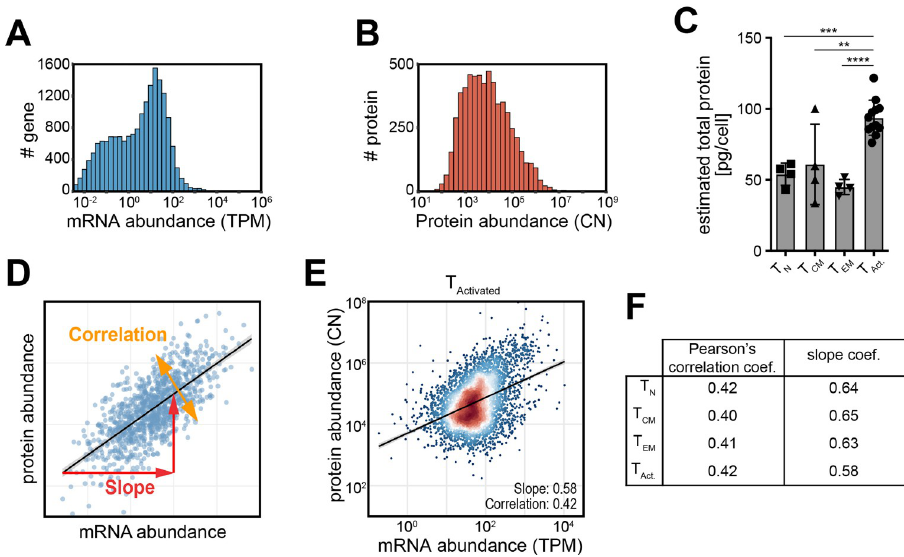
Fig 1. Transcriptome and proteome integration in human CD8 + T cells. ( A, B ) mRNA abundance in transcript per kilobase per million (TPM) and protein abundance data in protein copy number (CN) of CD8 + T cells that were activated for 2 days with α CD3/ α CD28, cultured for 4 days, and were then re-activated for 4h with PMA-Ionomycin (T Activated ; n = 12; from [23]). ( C ) Estimated protein mass per cells using the proteomic ruler methodology [25] of blood-derived, na ï ve (T N ; CD45RA + CD62L high ; n = 4), central memory (T CM ; CD45RO + CD62L high CX3CR1 - ; n = 4) and effector-memory (T EM ; CD45RO + , CD62L low , CX3CR1 high ; n = 4) CD8 + T cell subsets and for CD8 + T cells from (A). The p-value resulting from two-tailed t-test is indicated in (C). ( D ) Graph representing mRNA and protein correlation (such as Pearson’s correlation) and slope of a linear regression. Of note, the correlation coefficient represents a numerical integration of the dispersion of the data points and is not a measure of the angle of the regression line. ( E ) Integrated mRNA and protein abundance in T Activated . The Pearson’s correlation coefficient, the linear regression (grey line), and its mRNA-to-protein slope (also known as Beta-coefficient) are indicated in the graph. ( F ) Table indicating the Pearson’s correlation coefficient and the mRNA-to-protein slope for T cell populations in (C).